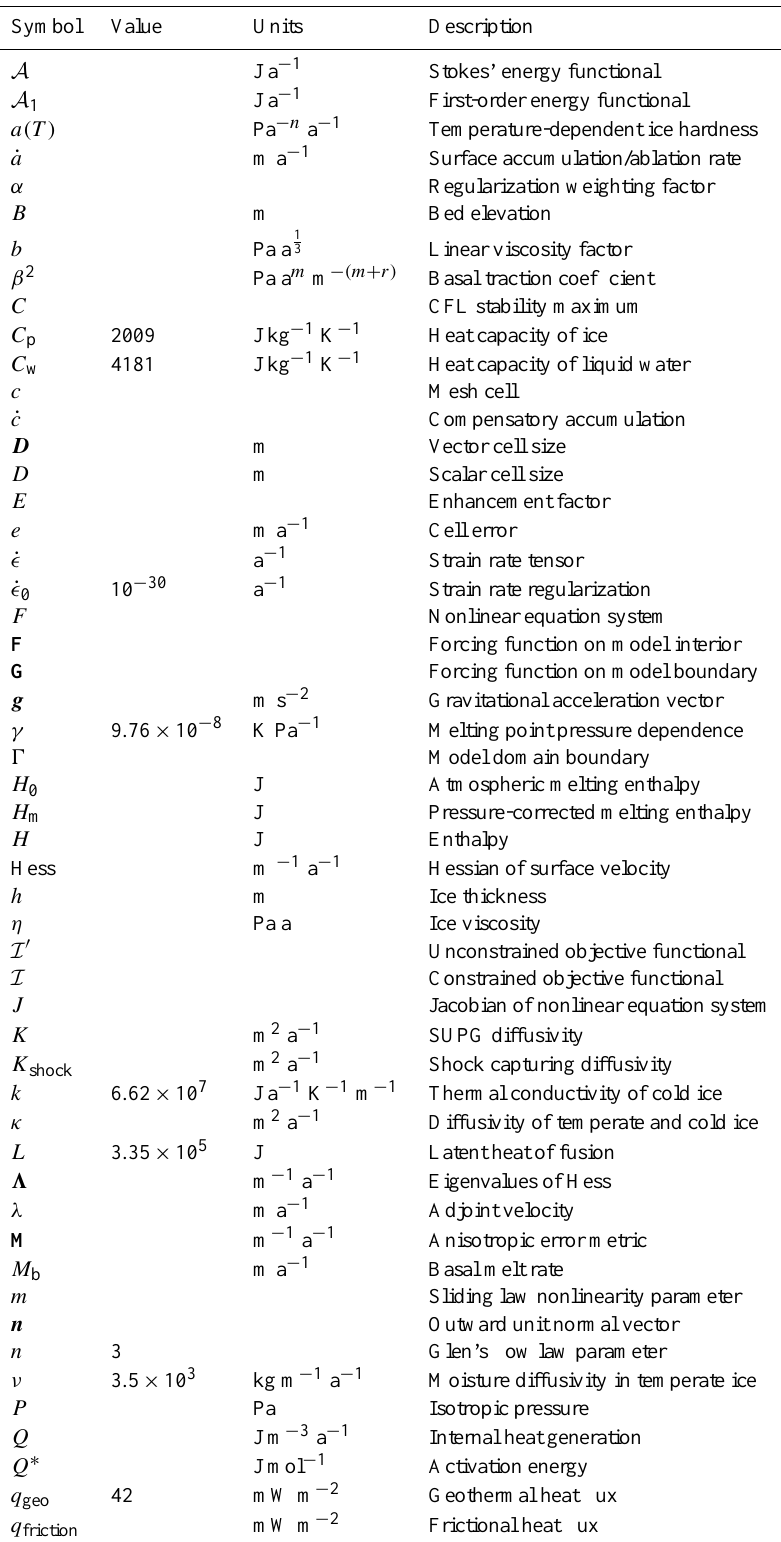
Table 1. Table of